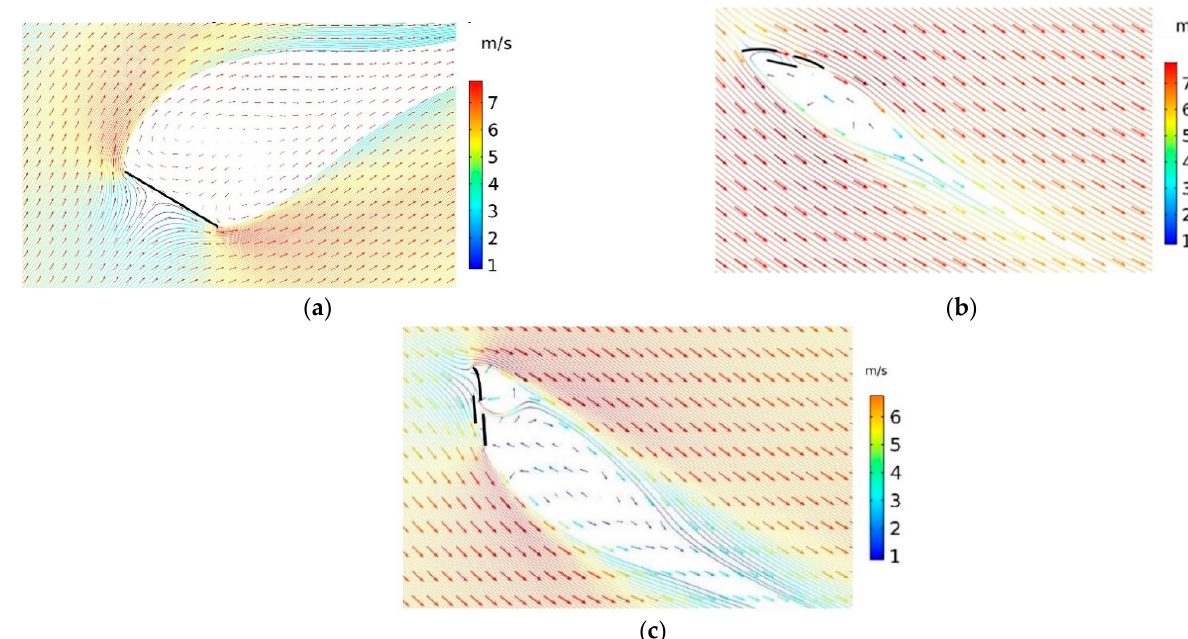
Figure 10. A 2D quasi steady COMSOL flow simulation of flapping wings according to the 30° inclined fuselage, and with an upstream velocity of 1.6 m/s and flapping frequency of 14 Hz (the total incident velocity is 4.68 m/s): ( a ) flow field of wing membrane with check-valve closing during downstroke, producing a lift of 9.83 gf; ( b ) flow field of wing membrane with check-valve opening during upstroke, producing a lift of − 4.43 gf; ( c ) flow field of 90°-inclined wing membrane with check-valve opening during upstroke, producing a lift of 3.15 gf.